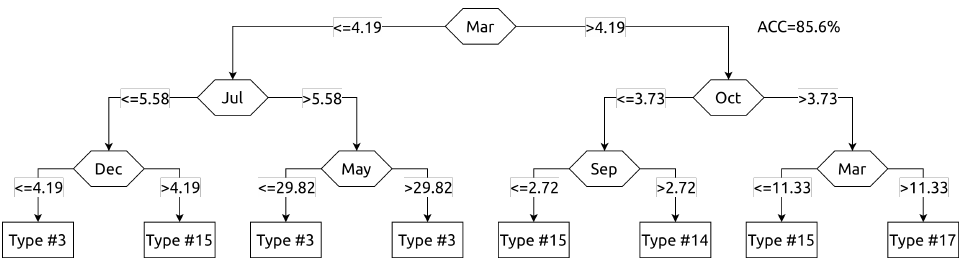
Figure 2. A single decision tree. The numbers on the arrows indicate the relative monthly river